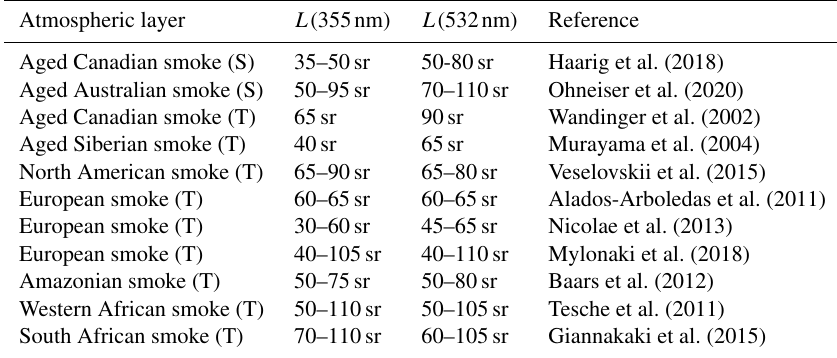
Table 1. Dual-wavelength lidar observations of lidar ratios ( L ) at 355 and 532nm in tropospheric (T) and stratospheric (S) smoke